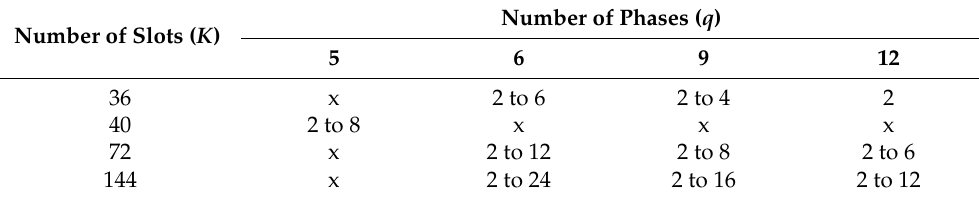
Table 1. The number of poles ( 2 p ) as a function of the number of slots ( K ) and the number of phases ( q ) .